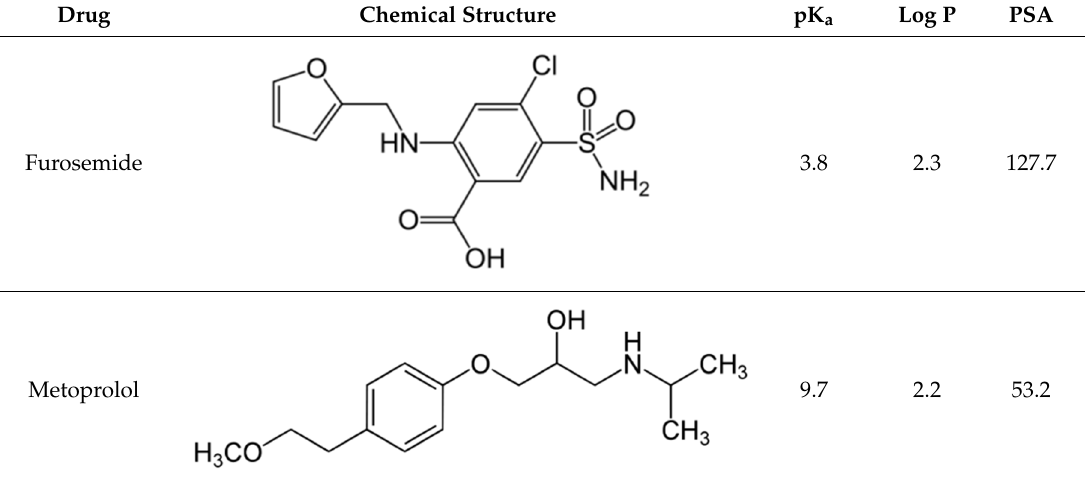
Table 2. Physicochemical parameters and chemical structure of furosemide and metoprolol. Drug Chemical Structure